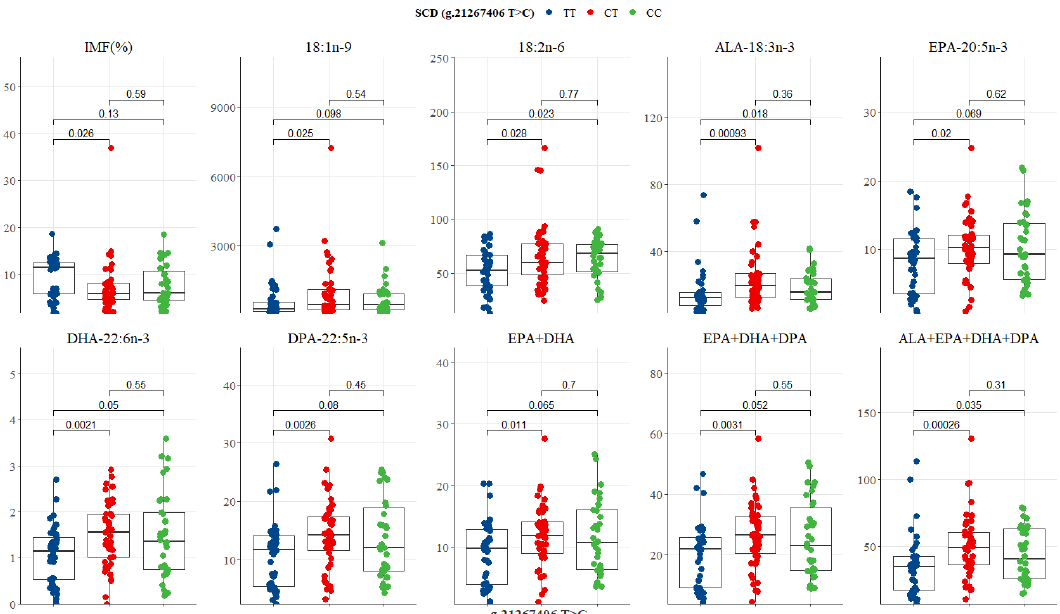
Figure 7. Tukey-adjusted multiple comparisons between an SCD SNP locus with IMF and fatty acid profiles of Bowen Genetics Forest Pastoral Angus, Hereford, and Wagyu. Each box plot tested the mean IMF, FMP, and fatty acids in TT versus CT, TT versus CC, and CT versus CC genotypes. Significant level set at ( p < 0.05).